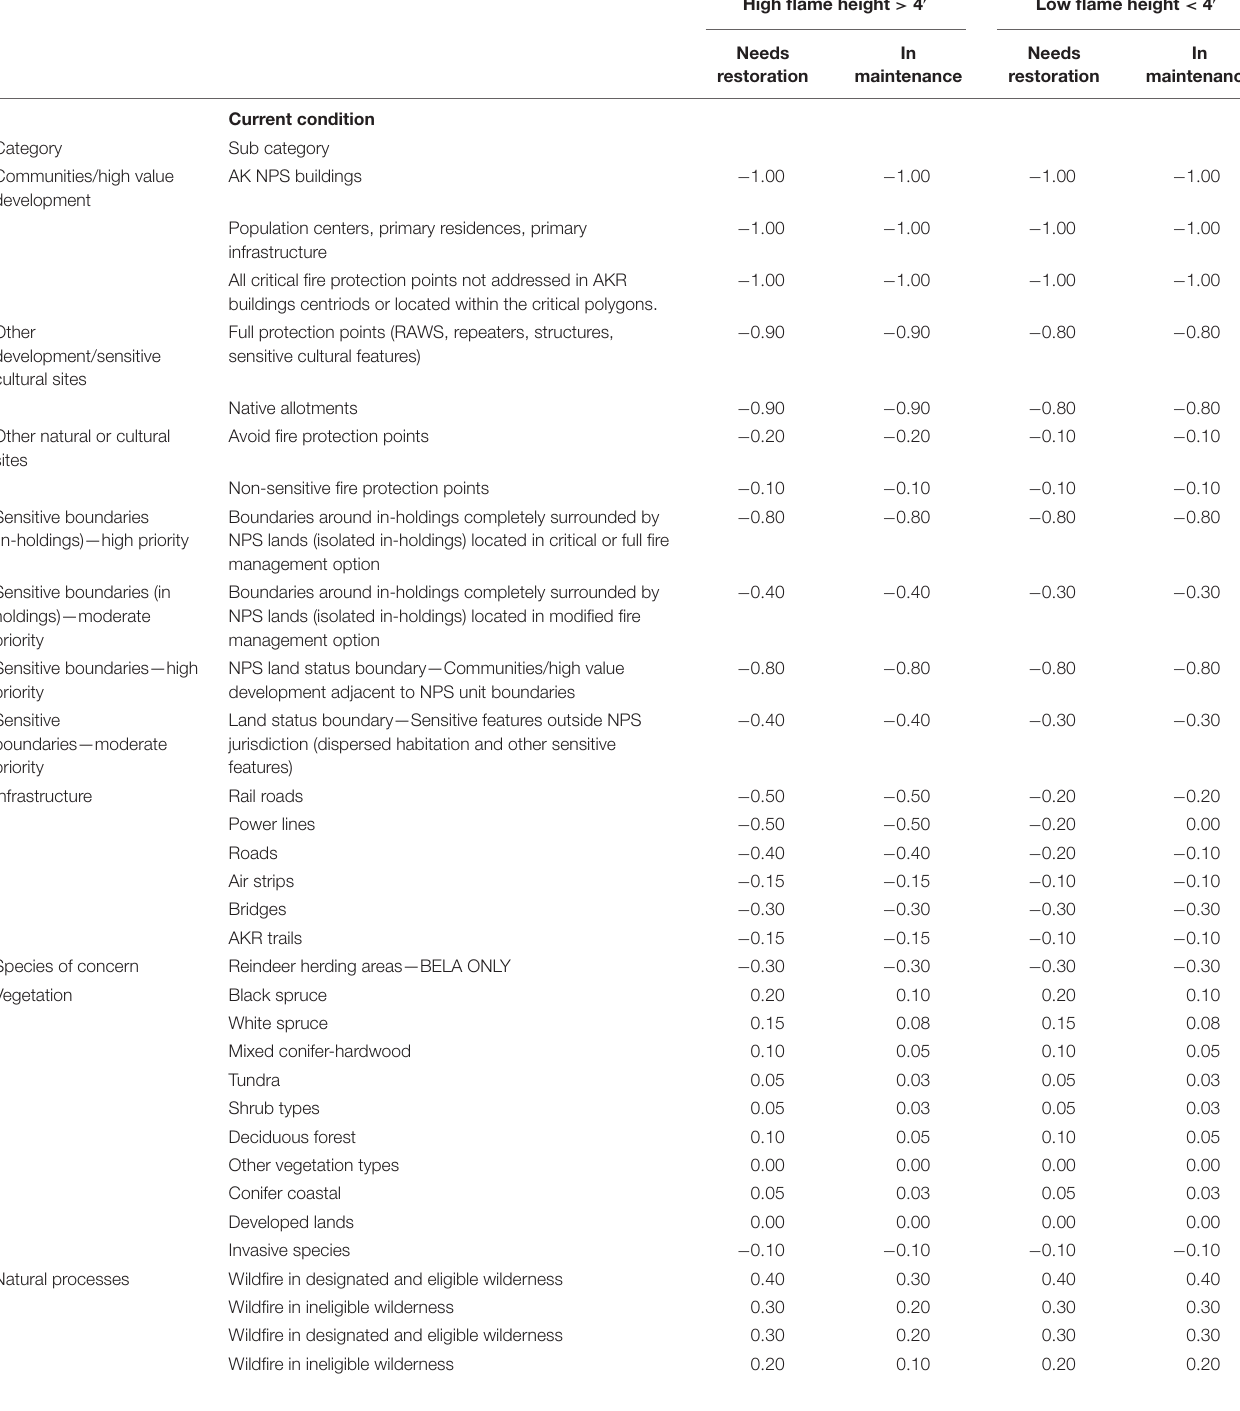
TABLE A1 | The use of marginal fire effective values in the AK study measured by WUI Coin (Rideout et al.,